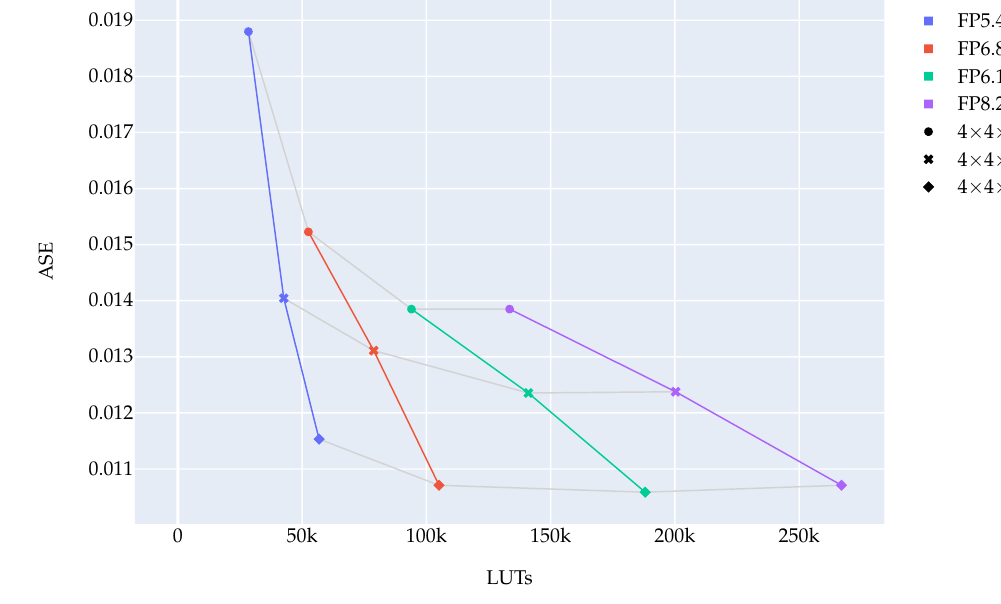
Figure 15. Average squared error versus